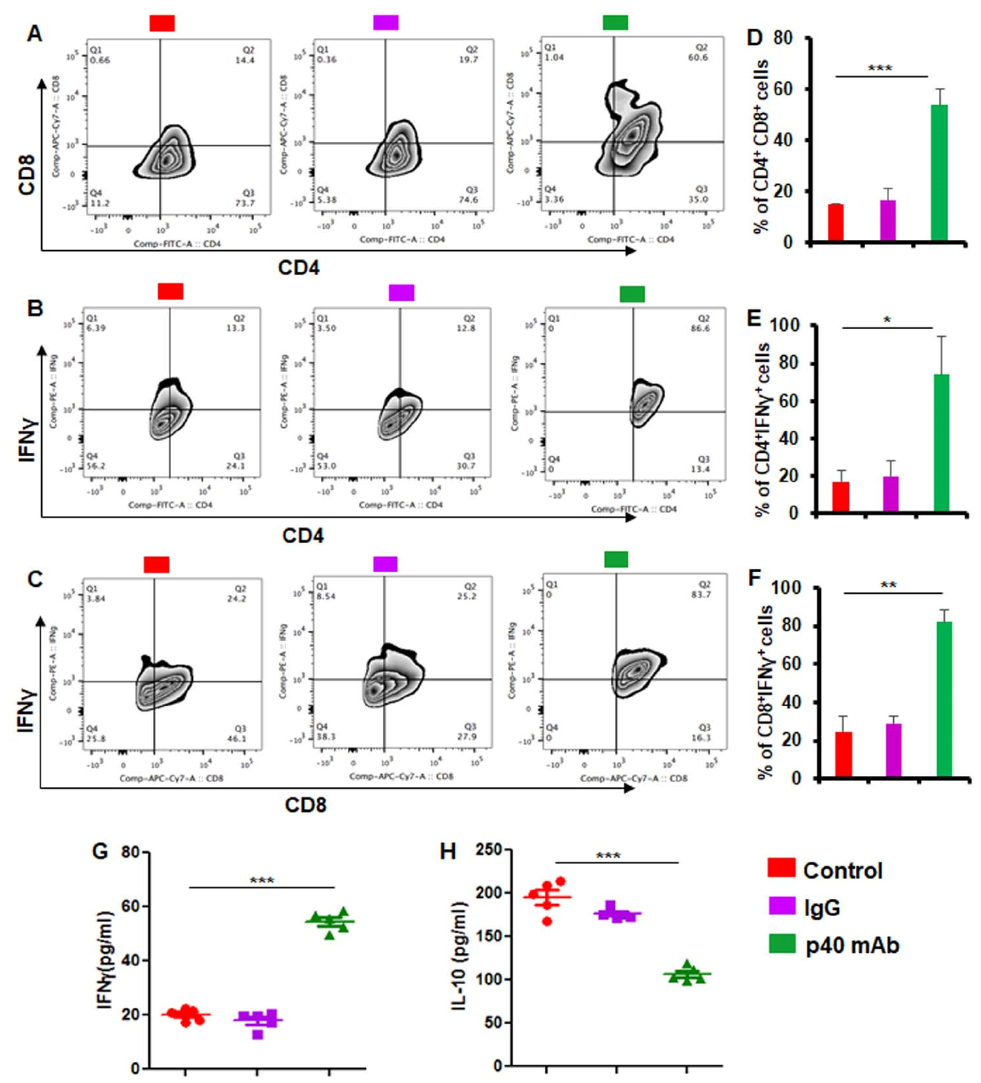
Figure 6. Neutralization of p40 by p40 mAb stimulates adaptive immune response in TNBC tumor of PDX mice. Female 6–8 week old NSG mice were engrafted TNBC tumor in the flank. After about 4 weeks of engraftment, when tumors of PDX mice were 0.6-0.8 cm 2 in size, mice were treated with p40 mAb and hamster IgG at a dose of 2 mg/kg body wt once a week. After 2 weeks of treatment, tumor tissues were harvested and levels of human CD4 + CD8 + ( A ), CD4 + IFN γ + ( B ) and CD8 + IFN γ + ( C ) T cells were monitored in single cell suspensions by FACS using a BD LSRFortessa™ cell ana ‐ lyzer. Percentages of human CD4 + CD8 + ( D ), CD4 + IFN γ + ( E ) and CD8 + IFN γ + ( F ) T cells were calcu ‐ lated. Results are mean + SEM of five mice ( n = 5) per group (one analysis per mouse). Levels of human IFN γ ( G ) and IL ‐ 10 ( H ) were measured in TNBC homogenates of all groups ( n = 5) of mice by sandwich ELISA. * p < 0.05; ** p < 0.01; *** p < 0.001. 3.7. The p40 mAb Treatment Upregulates M1 Macrophages while Suppressing M2 Ones in the Tumor Tissues of PDX Mouse Model of TNBC Tumor associated macrophages (TAMs) play a critical role in the pathogenesis of various cancers including TNBC [36]. TAMs usually polarize to either M1 exhibiting anti ‐ tumor activity or M2 with tumor promoting functions. While TAM1s express high amounts of inducible nitric oxide synthase (iNOS), TAM2s are characterized by arginase 1 (ARG1) [37]. Therefore, we examined the status of TAM1/TAM2 in TNBC tumor after p40 mAb treatment. As evident from Figure 8A,C, the number of iNOS + Iba1 + TAM1s that was low in control TNBC tumor dramatically increased after treatment with p40 mAb, but not control IgG.